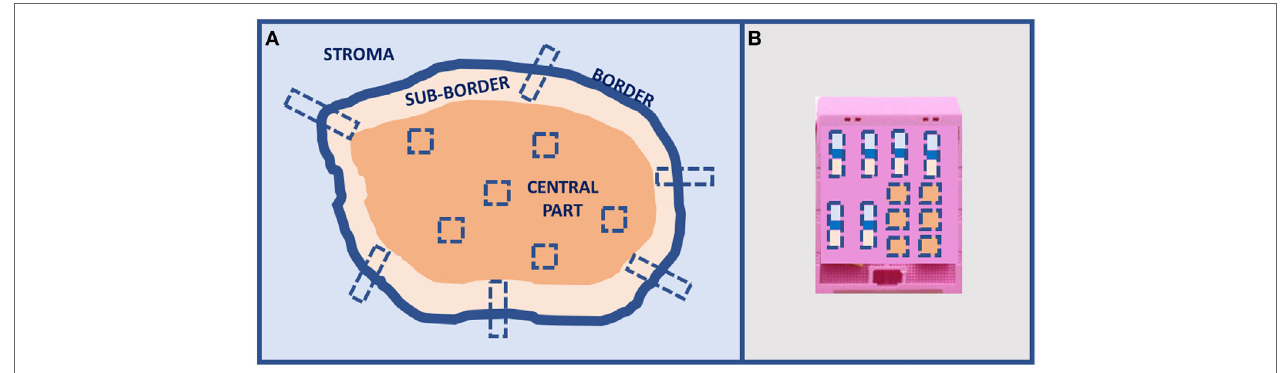
FiGURe 4 | Proposal of tumors larger than 2-cm sampling for in situ analyses: (A) multiple sampling locations and (B) organization in the inclusion